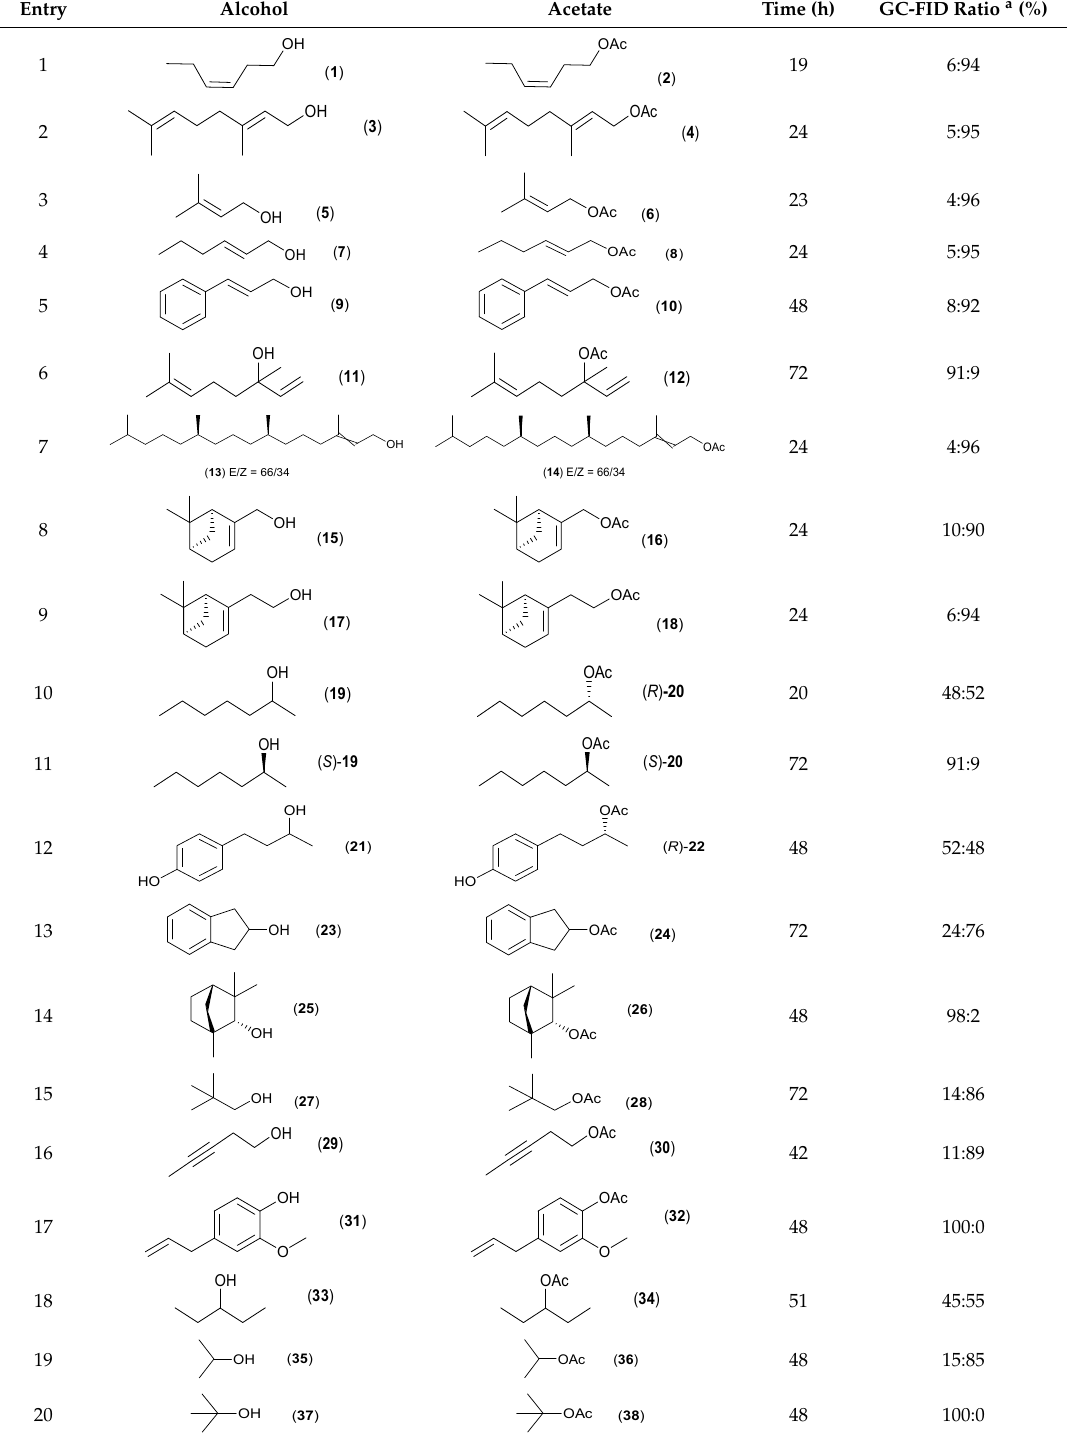
Table 1. Screening of the enzymatic acetylation of alcohols according to Scheme 2.